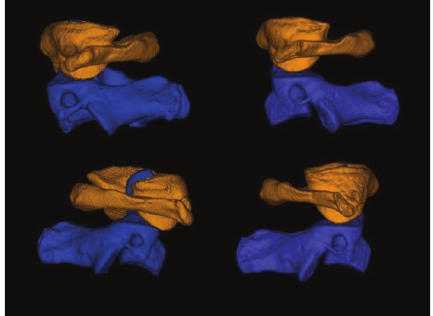
Figure 3: Lateral view from both sides before and after reduction in CT-VRT with segmentation of C1 and C2 (volume rendering technique).